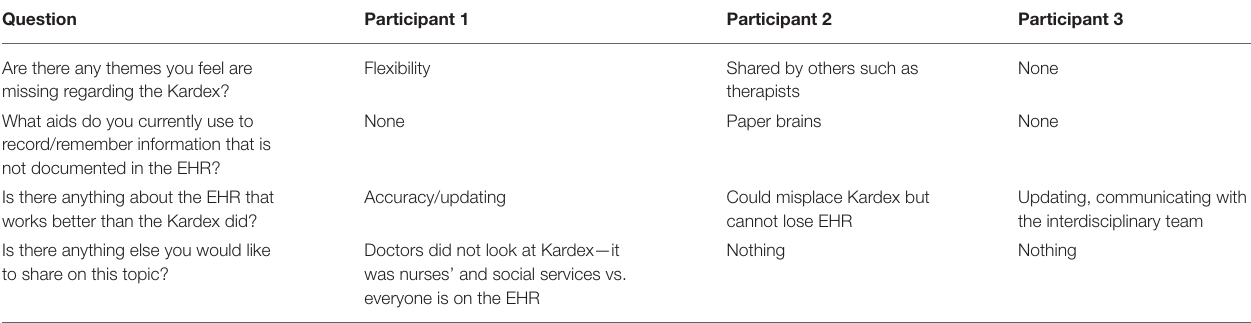
TABLE 5 | Validation interview summarized responses.